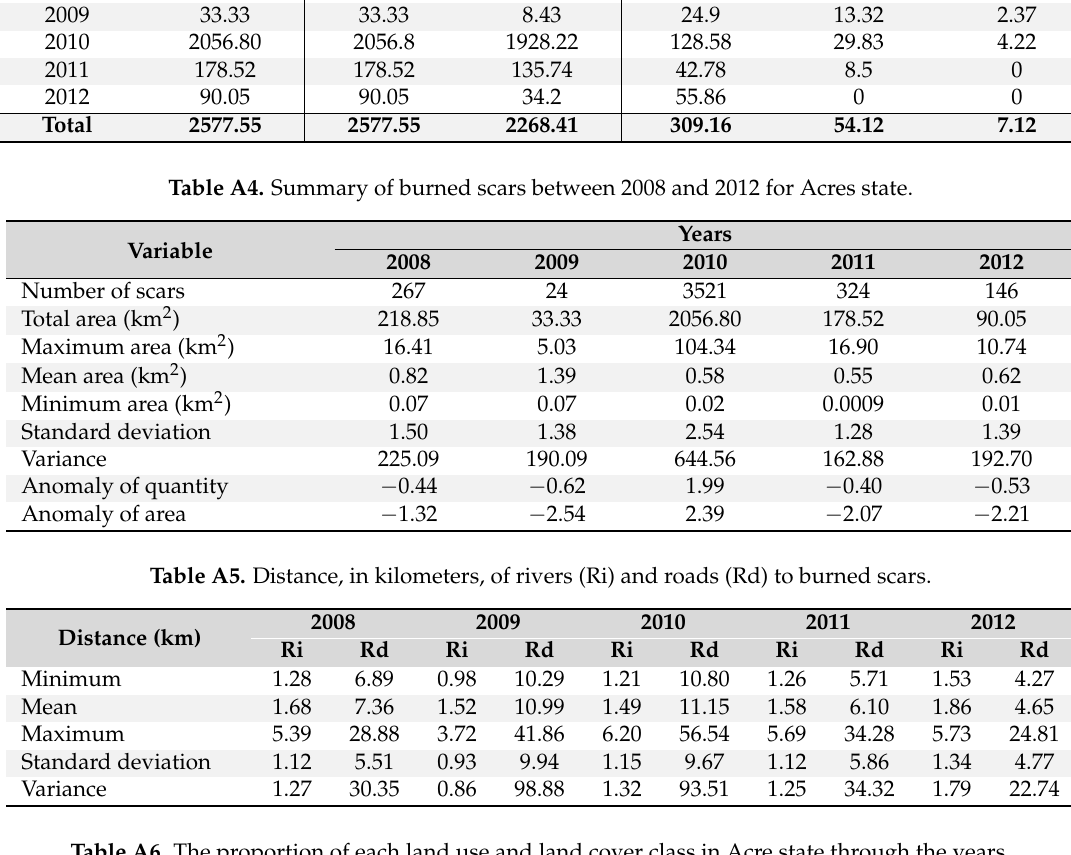
Table A6. The proportion of each land use and land cover class in Acre state through the